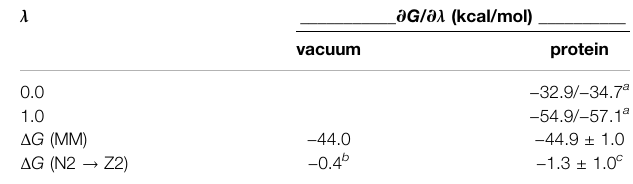
TABLE 2 | FEP for PLP N2/Z2